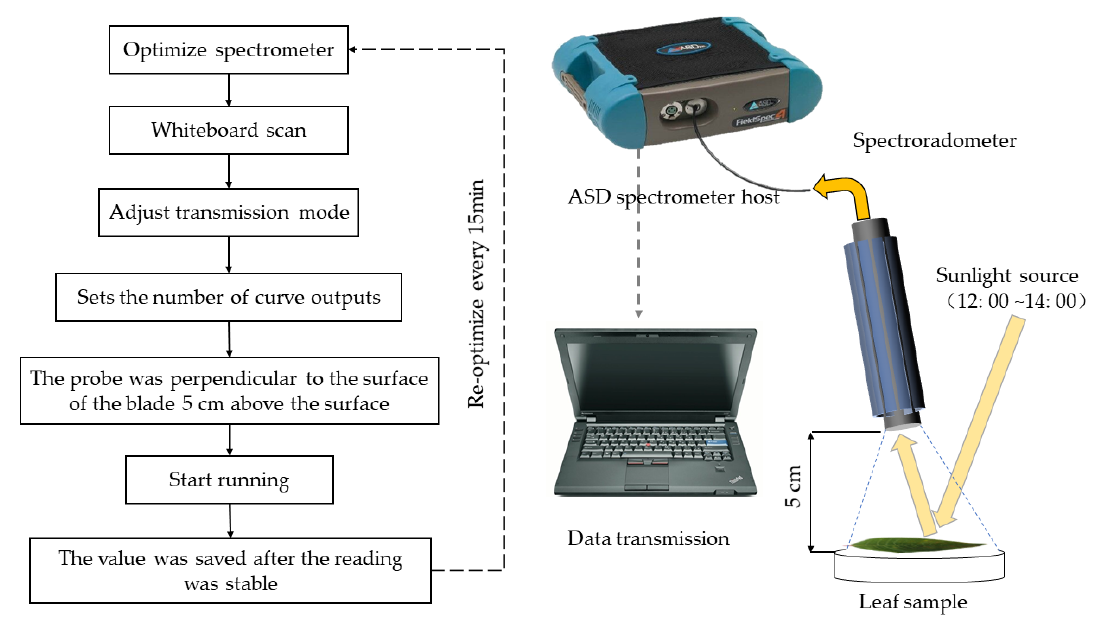
Figure 1. Flow chart of leaf spectrum measurement based on ASD spectrometer [16].